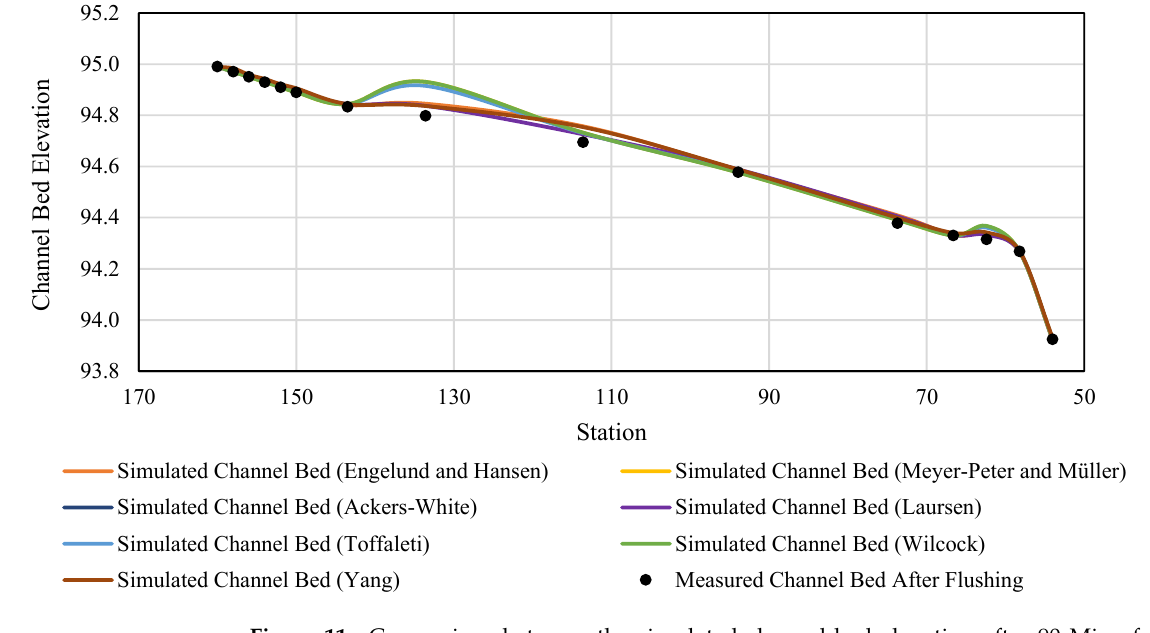
Figure 11. Comparison between the simulated channel bed elevation after 90 Min of flushing from several transport functions with the measured elevation in Scenario five. The upstream and downstream sections of the sand trap are on the left and right sides of the diagram. Table 5. Performance indicators of the sediment